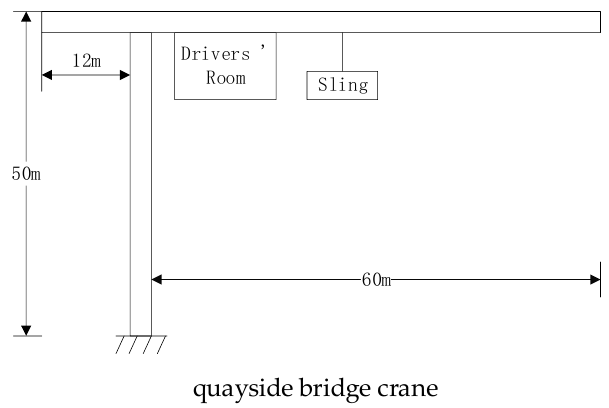
Figure 10. Equivalent conversion of trolley motion curve.